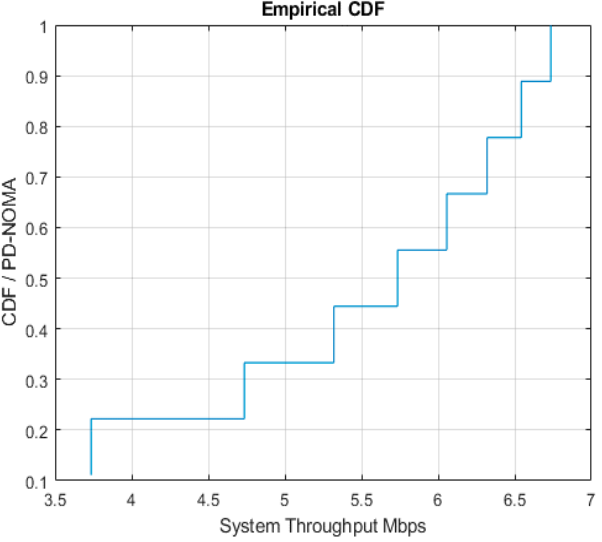
Figure 12. CDF of system throughput achieved with clustered PD-NOMA .